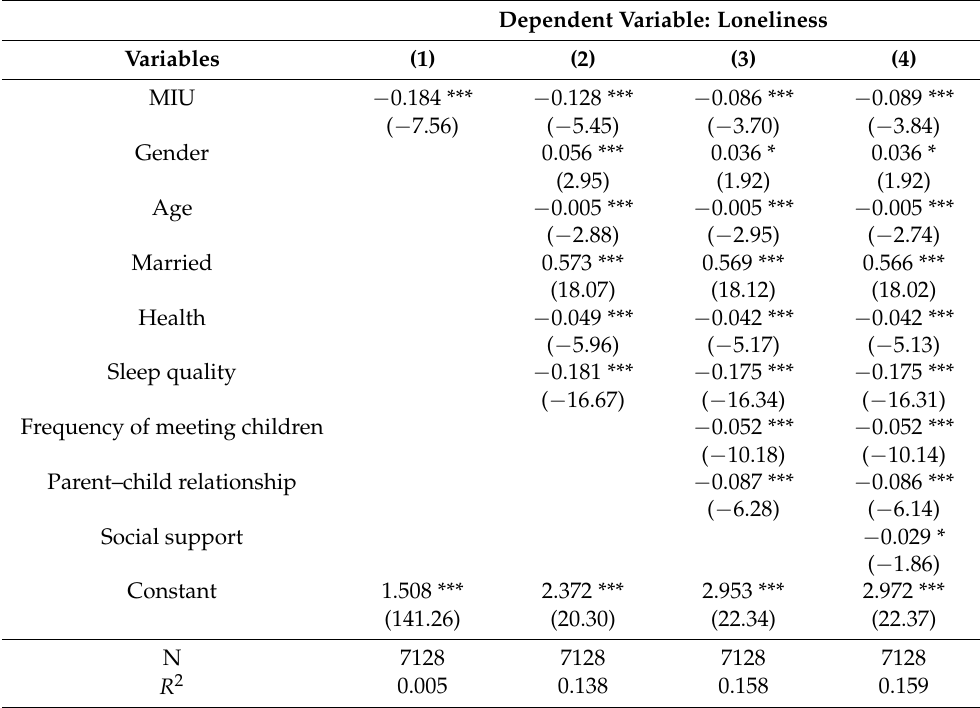
Table 2. OLS estimates of the effect of MIU on loneliness among older